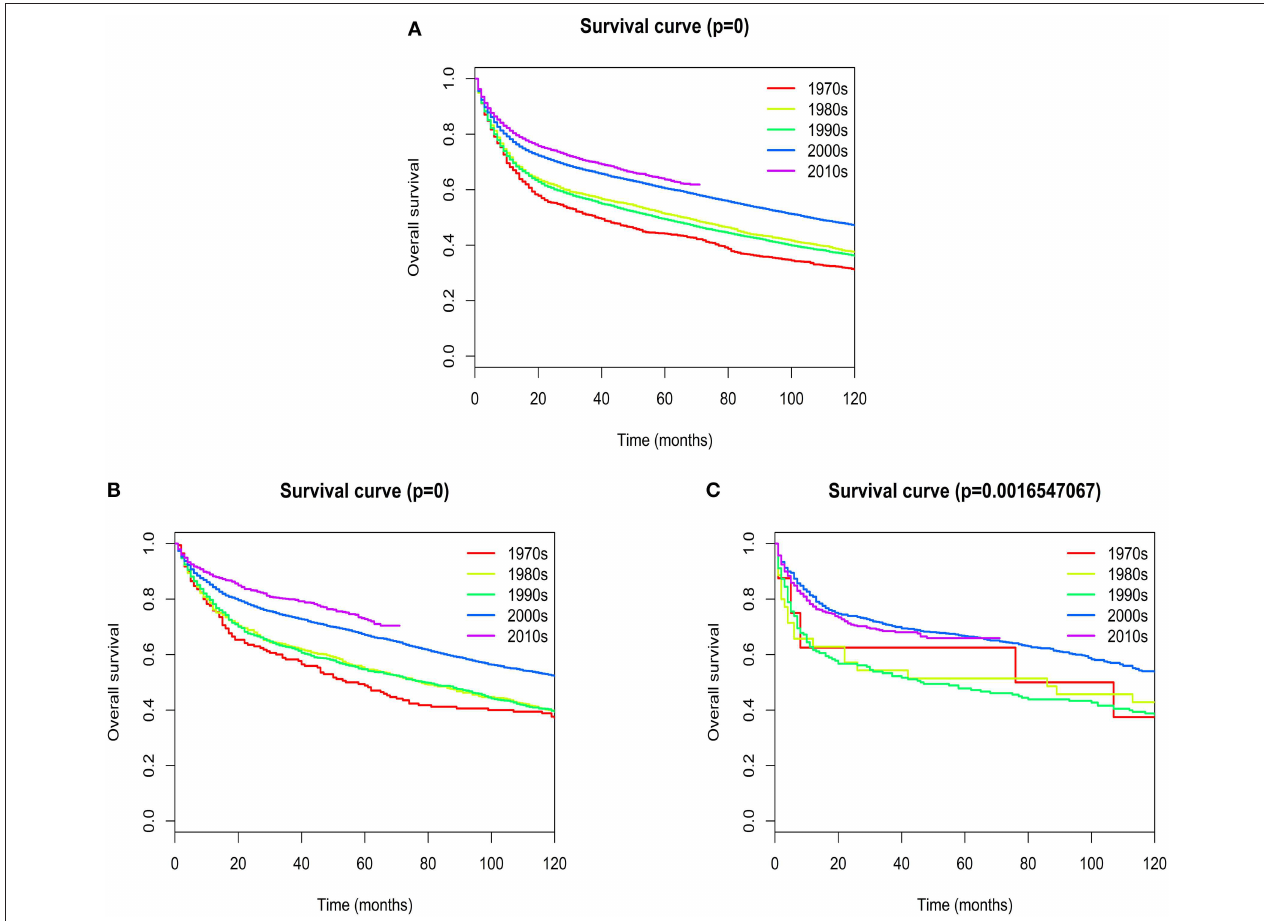
FIGURE 7 | Kaplan–Meier’s analysis for extranodal DLBCL. Graph shows increasing survival from the 1970s to 2010s. (A) Overall survival analysis; (B) Overall survival in Head/Neck; (C) Overall survival in Hematologic